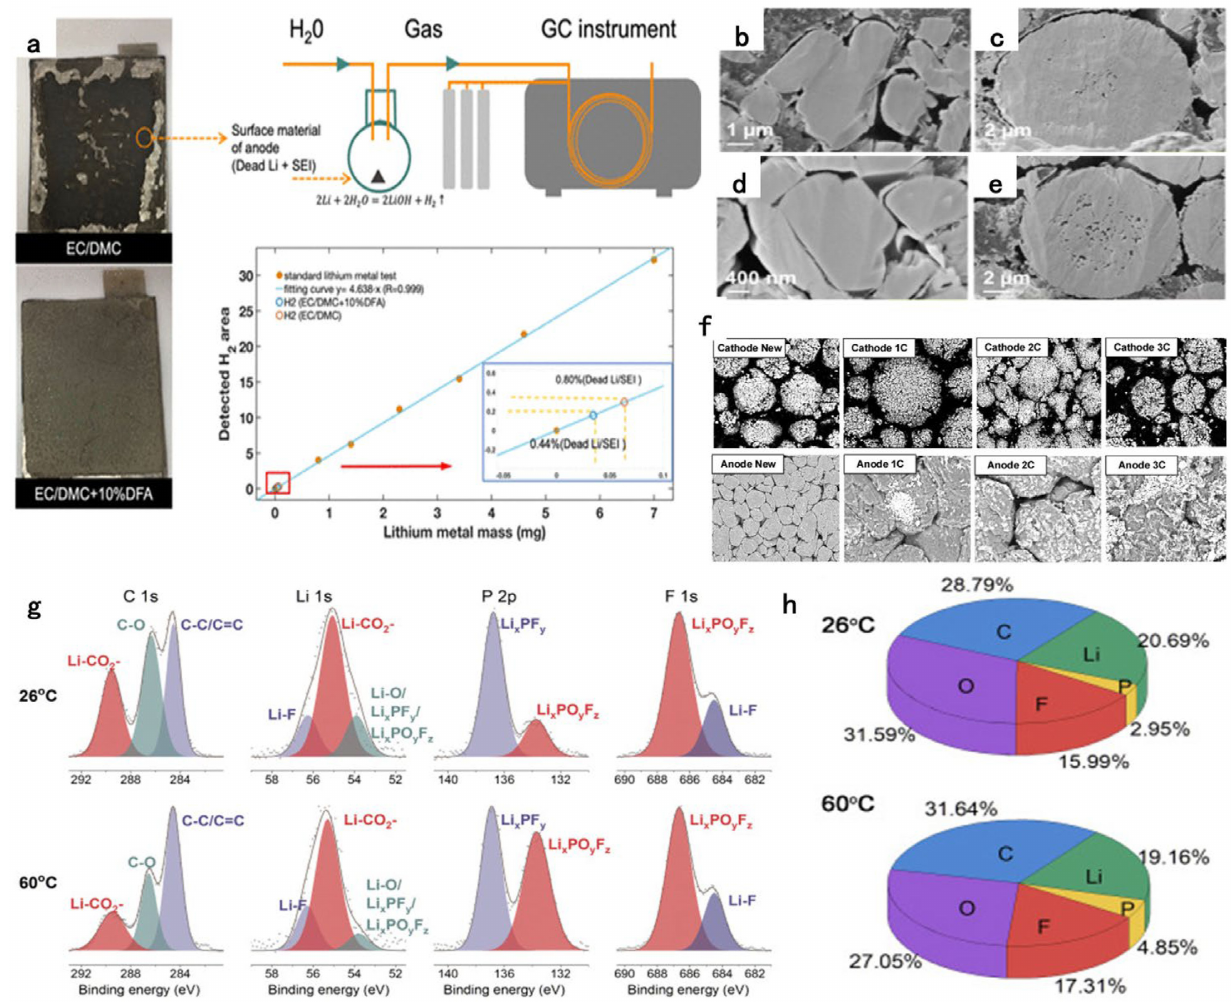
Figure 5. ( a ) Schematic diagram of TGC detection. Reprinted with permission from Ref. [76]. 2021, ACS Publications; ( b – e ) SEM test results of the cross-sections tests of four materials at 4.3 V; ( b ) SC-NCM622, ( c ) PC-NCM622, ( d ) SC-NCM811, ( e ) PC-NCM811. Reprinted with permission from Ref. [77] 2022, Elsevier; ( f ) the deposited layer and surface morphology of the cathode/anode material at 1C, 2C, and 3C charging C-rates by SEM. Reprinted with permission from Ref. [79]. 2020, Elsevier; ( g ) high-resolution XPS spectra of C 1s, Li 1s, P 2p, and F 1s of the anode samples from the 26 ◦ C and 60 ◦ C cells; ( h ) elemental concentration of the anode samples from the 26 ◦ C and 60 ◦ C cells. Reproduced with permission. Reprinted with permission from Ref. [80]. 2019,